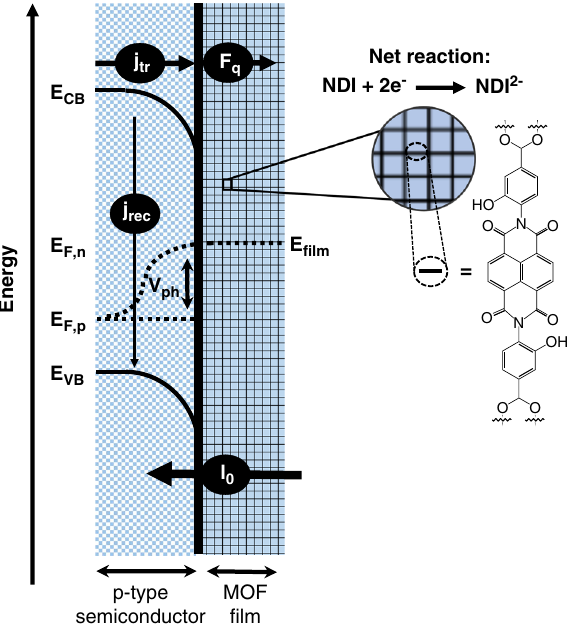
Fig. 1 Balance of steady-state photon ( I 0 ), interfacial electron transfer ( j tr ), recombination ( j rec ), and diffusion-controlled charge ( F q ) fl uxes. E VB and E CB are the energetic positions of the valence and conduction band, respectively, E F,p and E F,n are the quasi-Fermi levels of the holes and electrons, respectively, V ph is the semiconductor photovoltage, and E fi lm is the electrochemical potential of the MOF fi lm. The molecular structure of the linker is pictured on the